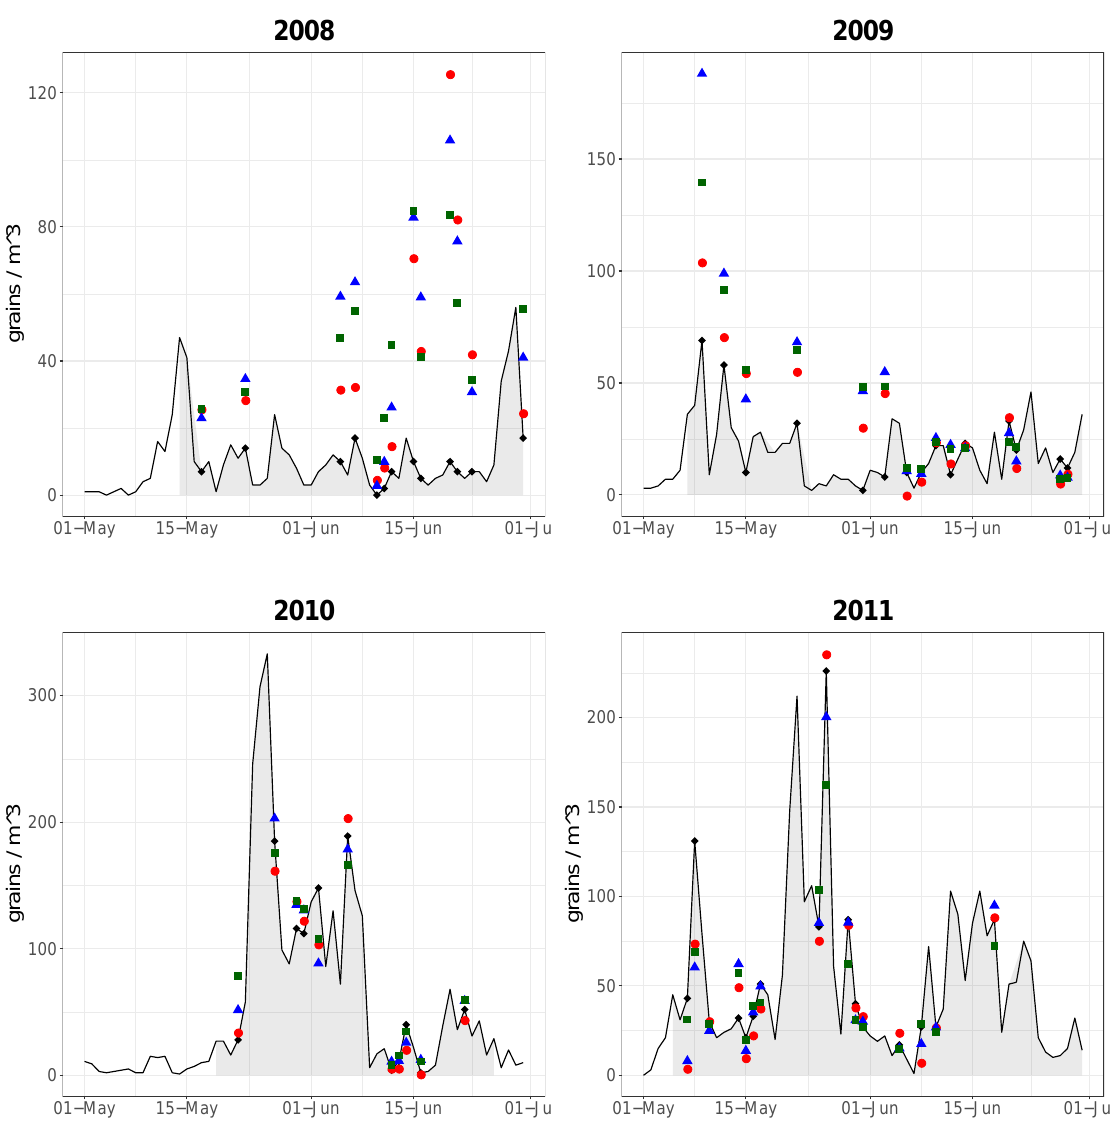
Figure 3. Sample estimation points during peak seasons (grey area) in 2008 to 2011 representing CNN (red circle), GPR(blue triangle), and IDW (green square). The missing observed data points are represented by a black